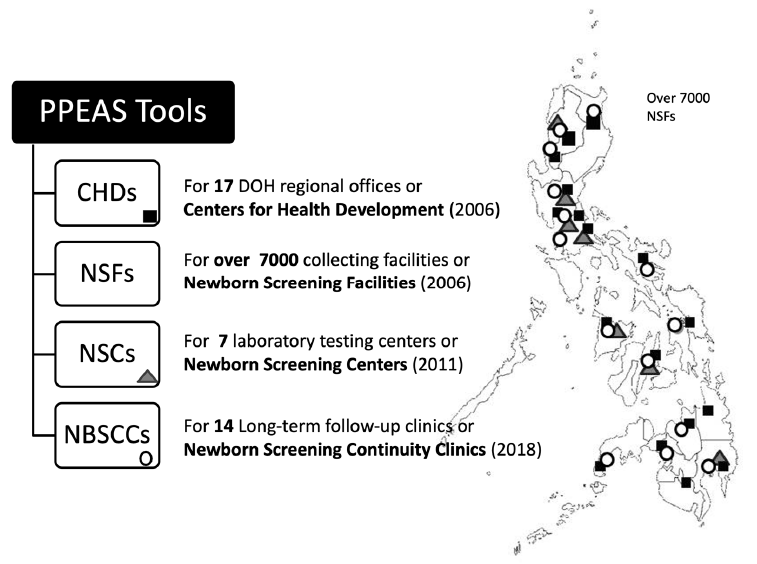
Figure 3. Identification on the various entities involved in Philippine NBS and Philippines performance evaluation and assessment scheme (PPEAS) evaluations